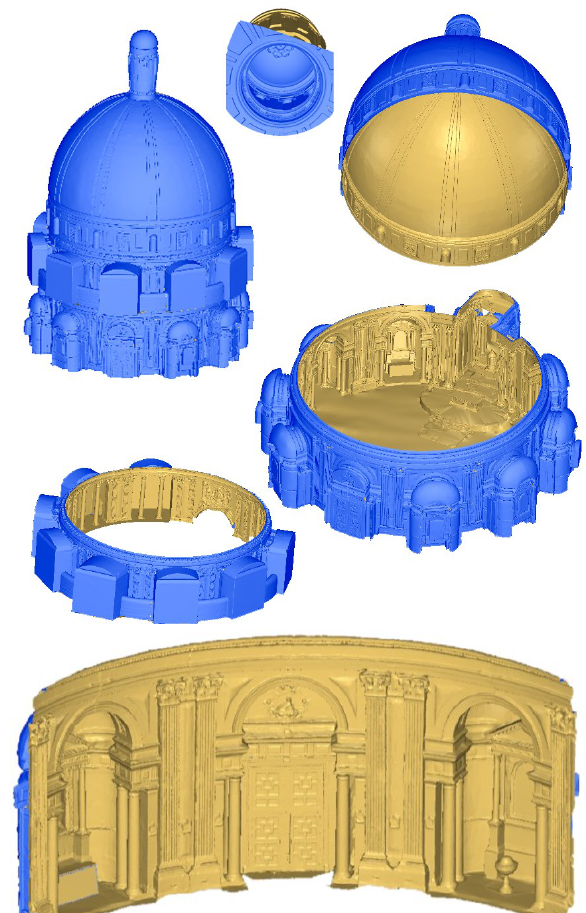
Figure 7. The 3D mesh of the Escuelas Pías